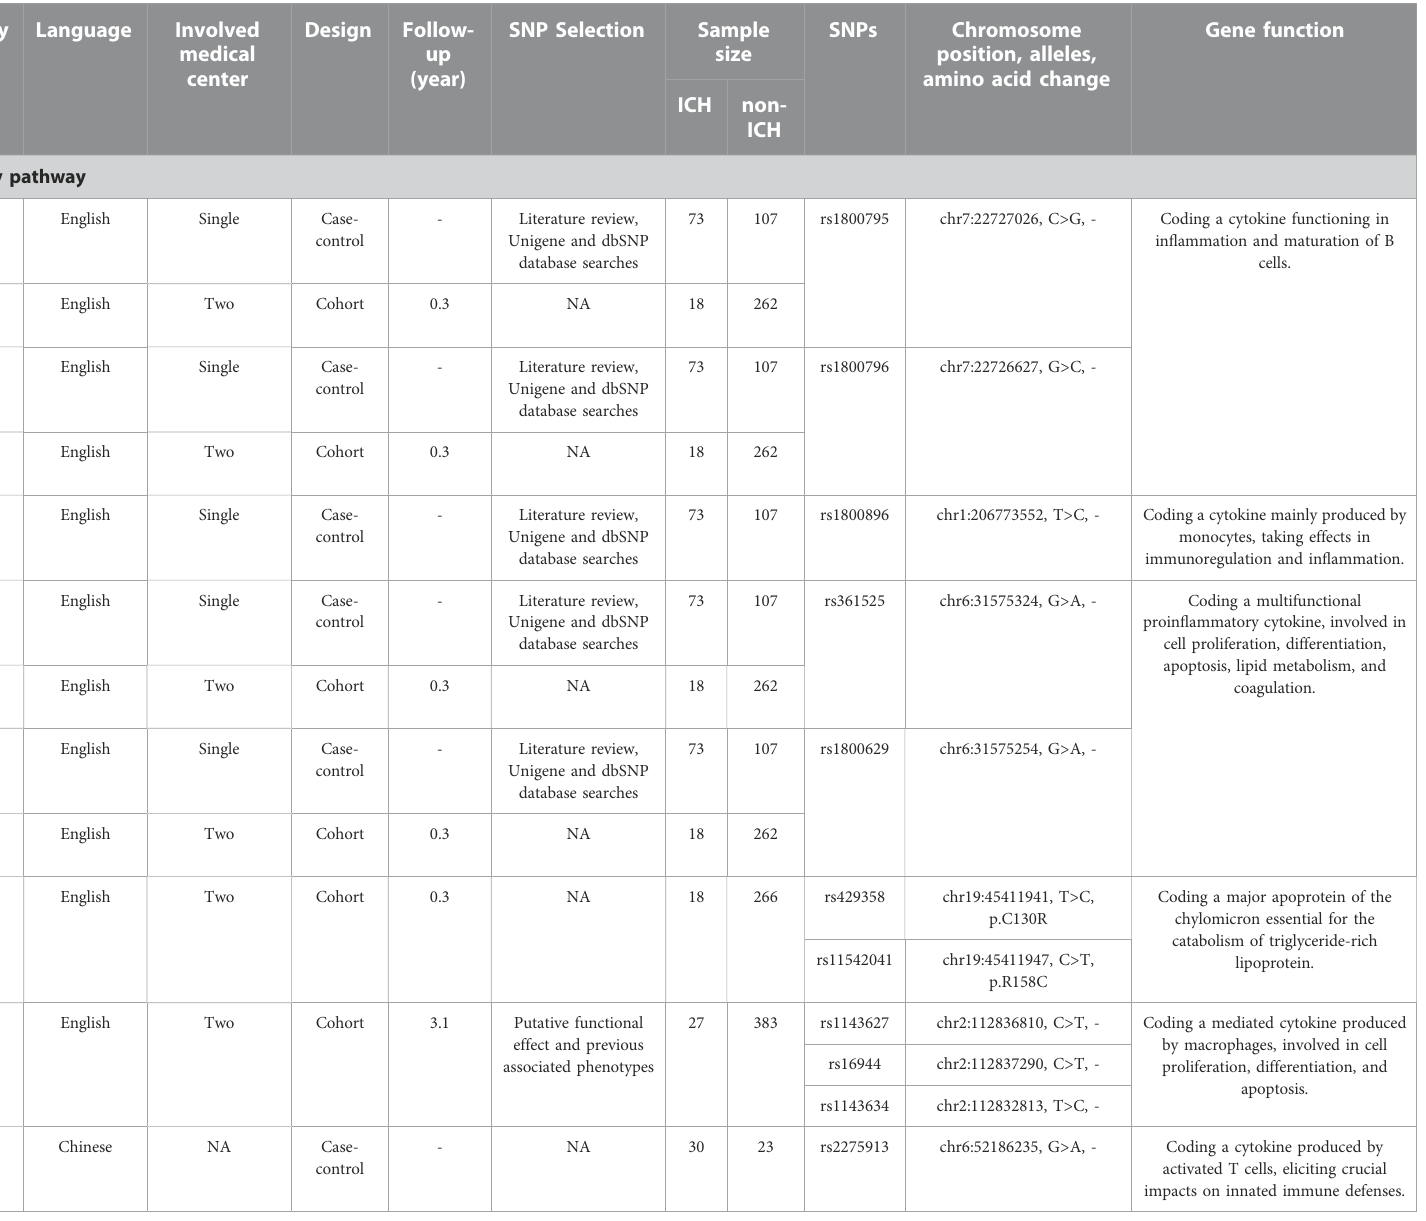
TABLE 1 Summary of the included genetic studies on brain arteriovenous malformation related hemorrhage.